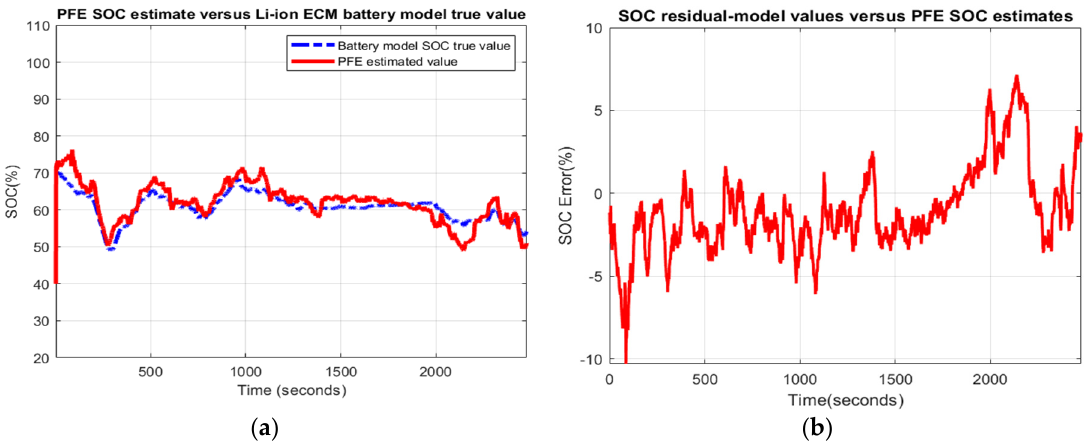
Figure A25. Robustness to changes in SOC initial value—SOCini = 0.4. ( a ) PFE SOC estimate versus 3RC ECM Li-ion battery SOC true value; ( b ) SOC residual. Batteries 2020 , 6 , x FOR PEER REVIEW